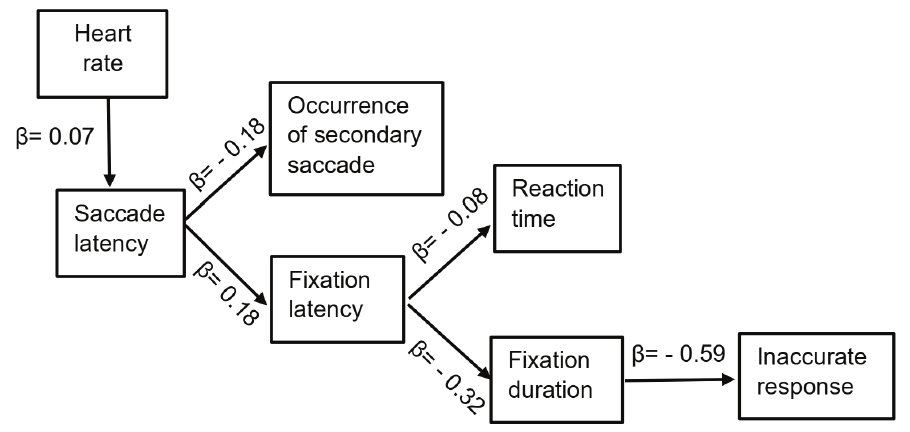
Figure 2. Illustration of final Path Models for the indirect effects of the changes in the cognitive load indicated by heart rate, from low to high load on subjects’ reaction time and submission of inaccurate